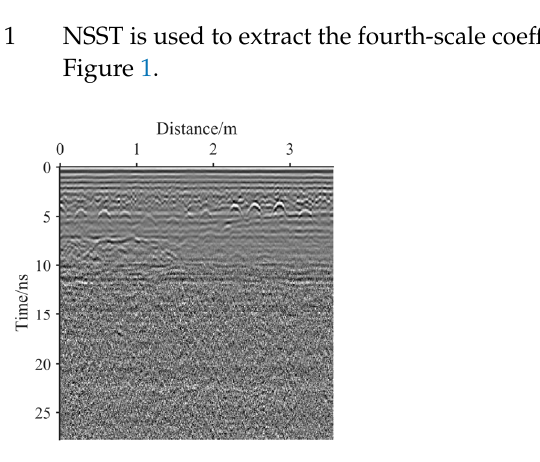
Figure 1. The real GPR image.